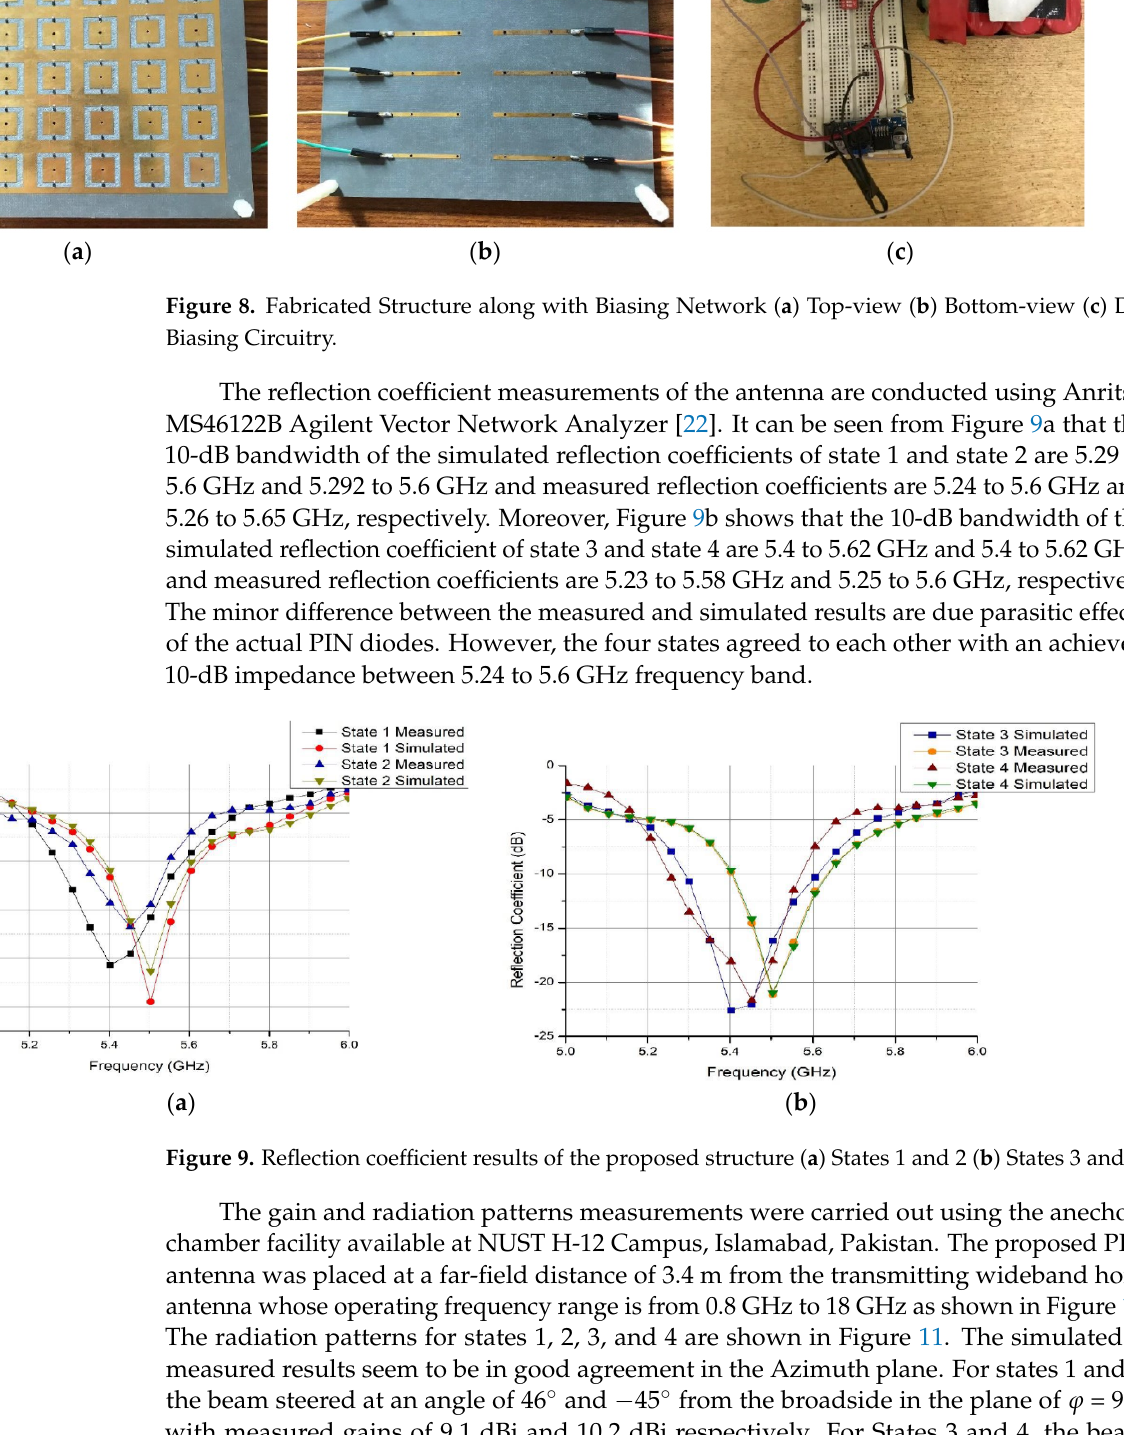
Figure 9. Reflection coefficient results of the proposed structure ( a ) States 1 and 2 ( b ) States 3 and